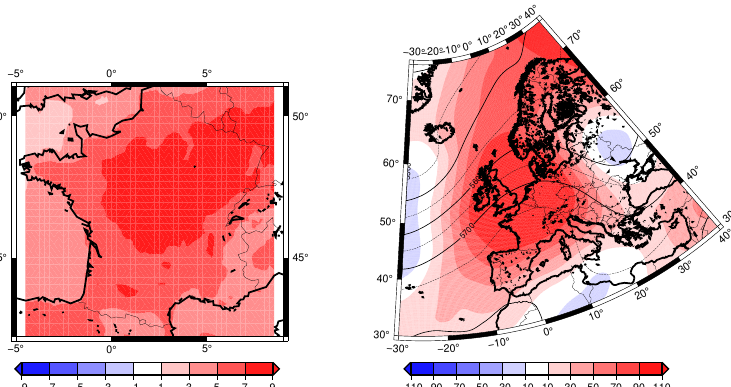
Figure 2. Left panel : mean anomalies of T2m over France between 31 July 2003 and 17 August 2003. Right panel : mean anomalies of Z500 (in m) over the East North Atlantic region (colours). Contour lines indicate the mean Z500 (in m).